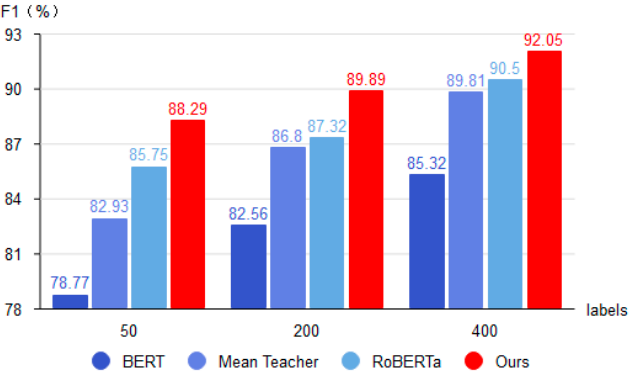
Figure 6. F1 score results for the IMDb dataset.